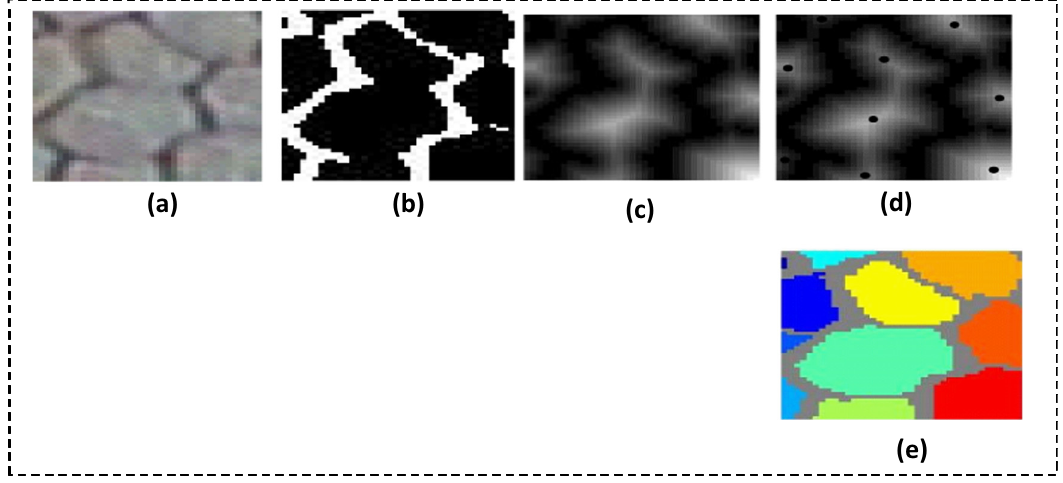
Figure 13: ( a ) Endothelial cells with original greyscale pixels, ( b ) binary image of overlapping objects, ( c ) distance transform of the image, ( d ) marker control for the cells, and ( e ) watershed transform